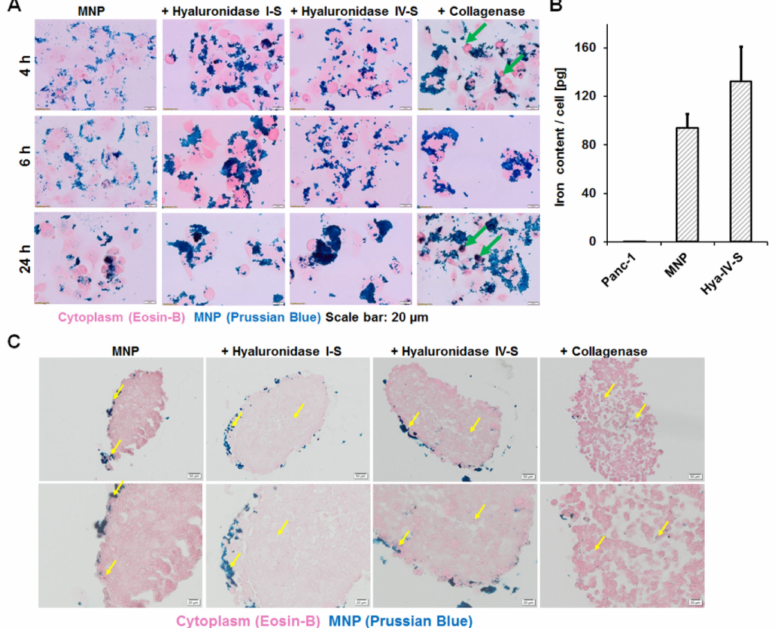
Figure 2. Matrix-modifying enzymes cause increased cellular uptake of MNP in pancreatic cancer cells. ( A ) Representative light microscopic images of Prussian blue-stained MNP in pancreatic cancer cells pretreated with 40 µ g/mL of the indicated hyaluronidases or 20 µ g/mL of collagenase in serum-free medium for 2 h, before incubation with 10 µ g Fe/mL MNP in growth media containing FCS for the indicated duration. Collagenase caused a higher rounding of the cells from the culture vessels (green arrows) than the hyaluronidases. ( B ) Comparative levels of iron per cell after exposure to MNP without or with pretreatment with hyaluronidase IV-S (Hya-IV-S), n = 3/S.D., p = 0.09 for MNP versus Hya-IV-S. ( C ) Representative light microscopic images of Prussian blue-stained 3D spheroid slices showing characteristic blue stain of MNP-based iron without or with pretreatment with 40 µ g/mL of hyaluronidases or 20 µ g/mL of collagenase in serum-free medium for 4 h before exposure to 50 µ g Fe/mL of the MNP in complete growth media for 24 h. MNP alone shows no loosening of the spheroid stroma and MNP only on the spheroid surface. The hyaluronidases caused moderately dissociated stroma and very high MNP uptake by cells lining the spheroid surface and a few in the spheroid center (yellow arrows), whereas collagenase caused strongly dissociated stroma and deep MNP-infiltration. Scale bars: upper images 50 µ m and lower images 20 µ